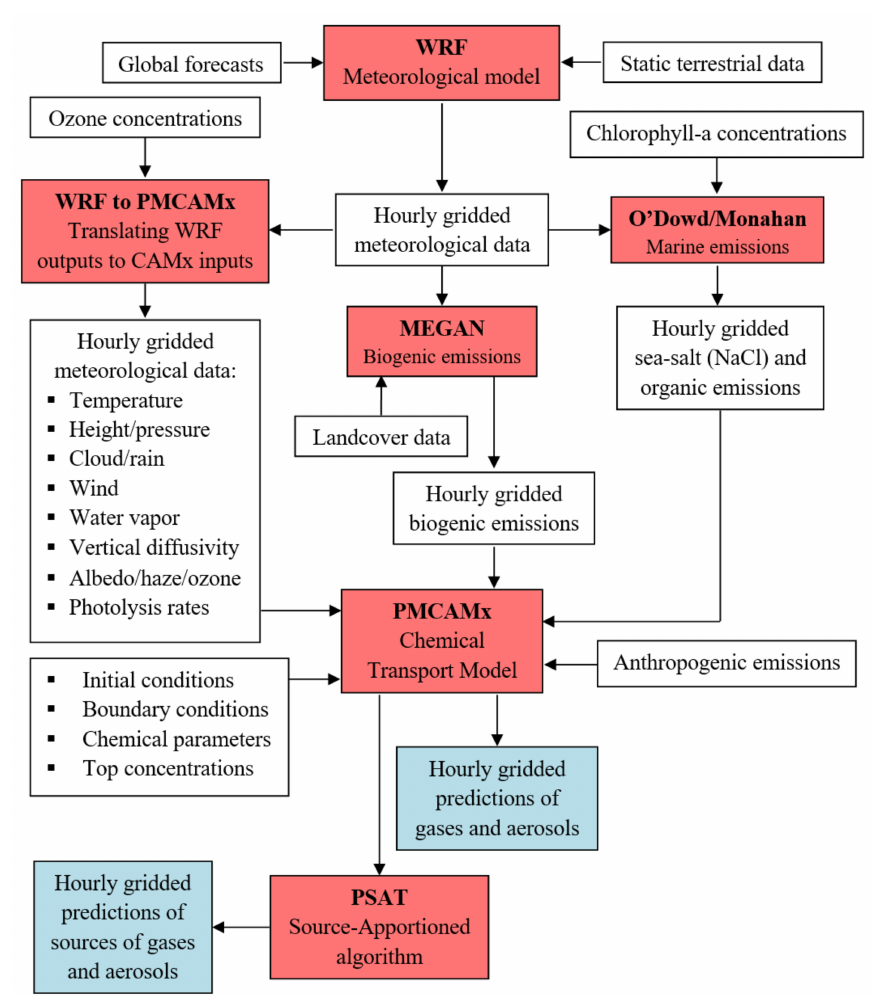
Figure 1. Simplified flow chart for SmartAQ. The modules used are in red boxes. Inputs and outputs of modules are in white boxes. Main outputs for pollutant predicted concentrations are in blue